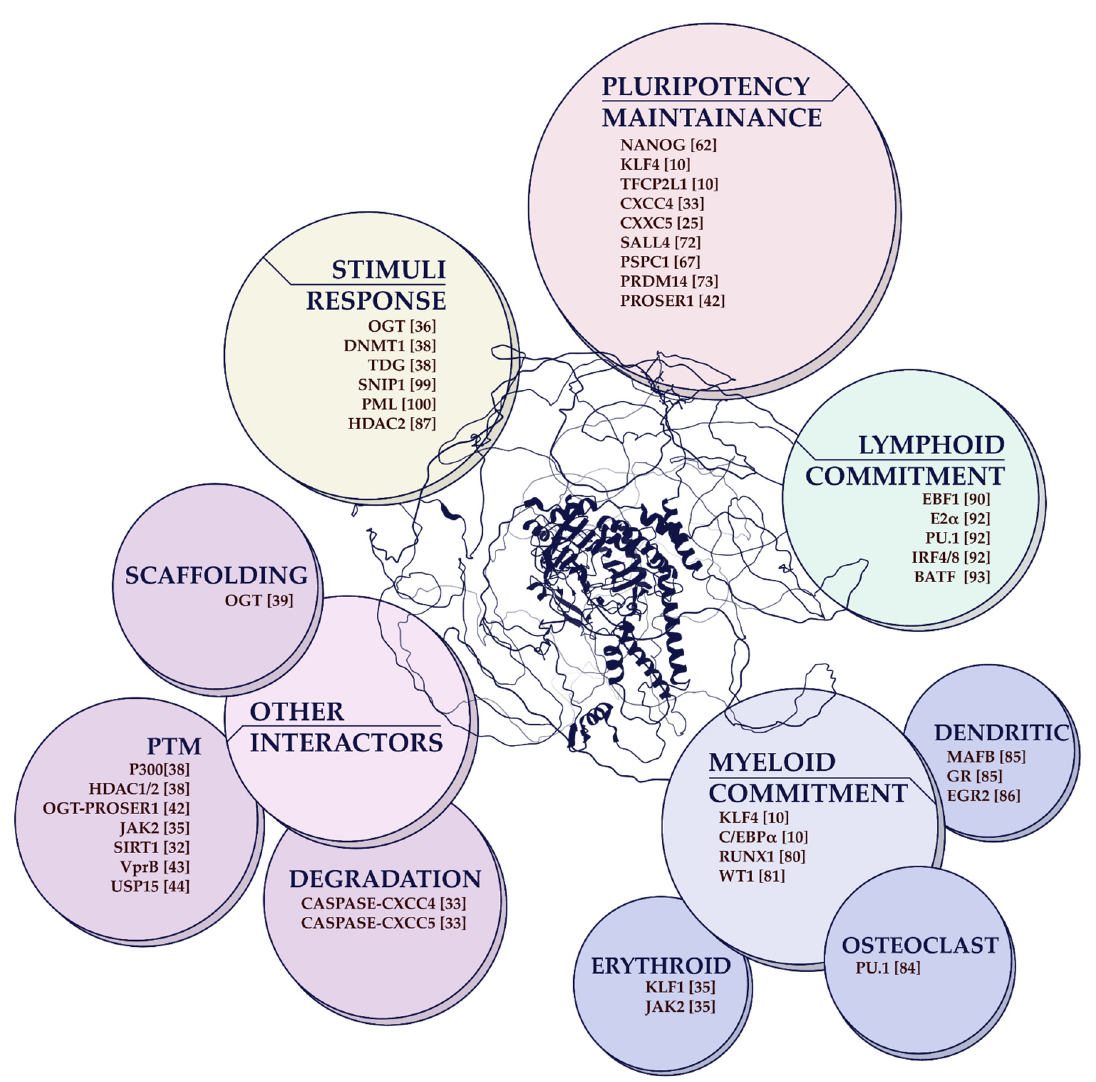
Figure 2. Graphical overview of TET2 protein partners/interactors. In the center, the human TET2 AlphaFold Database predicted protein structure (last updated on 1 July 2021 with AlphaFold v2.0) [57,58]. Encompassing the TET2 protein structure, color-coded bubbles cluster TET2 interactors based on previously described cell fate implications and physiological responses when cooperating with TET2. GR: glucocorticoid receptor.